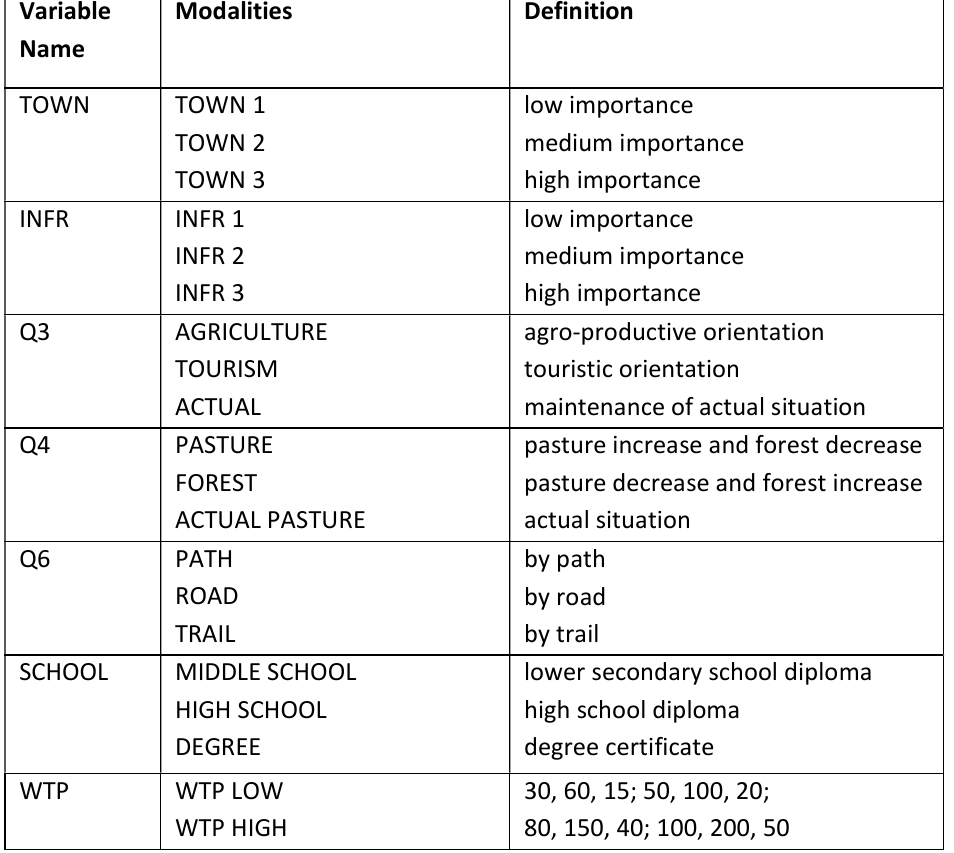
Table 4: MCA variables and their